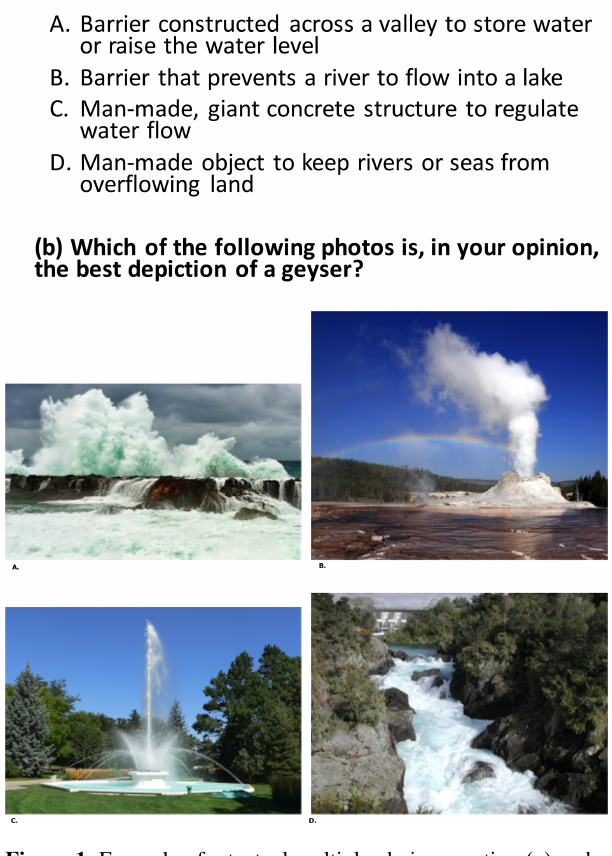
Figure 1. Example of a textual multiple-choice question (a) and a pictorial question (b) from the